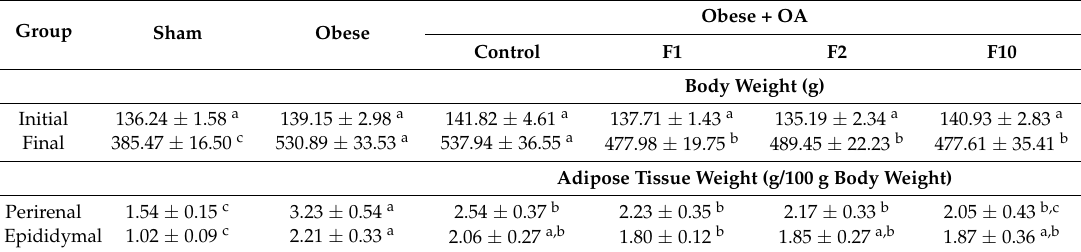
Table 1. The body weight and adipose tissue weight of high ‐ fat diet ‐ induced obese male rats that have an anterior cruciate ligament transection and a partial medial meniscectomy (ACLT + MMx) surgery induced OA.